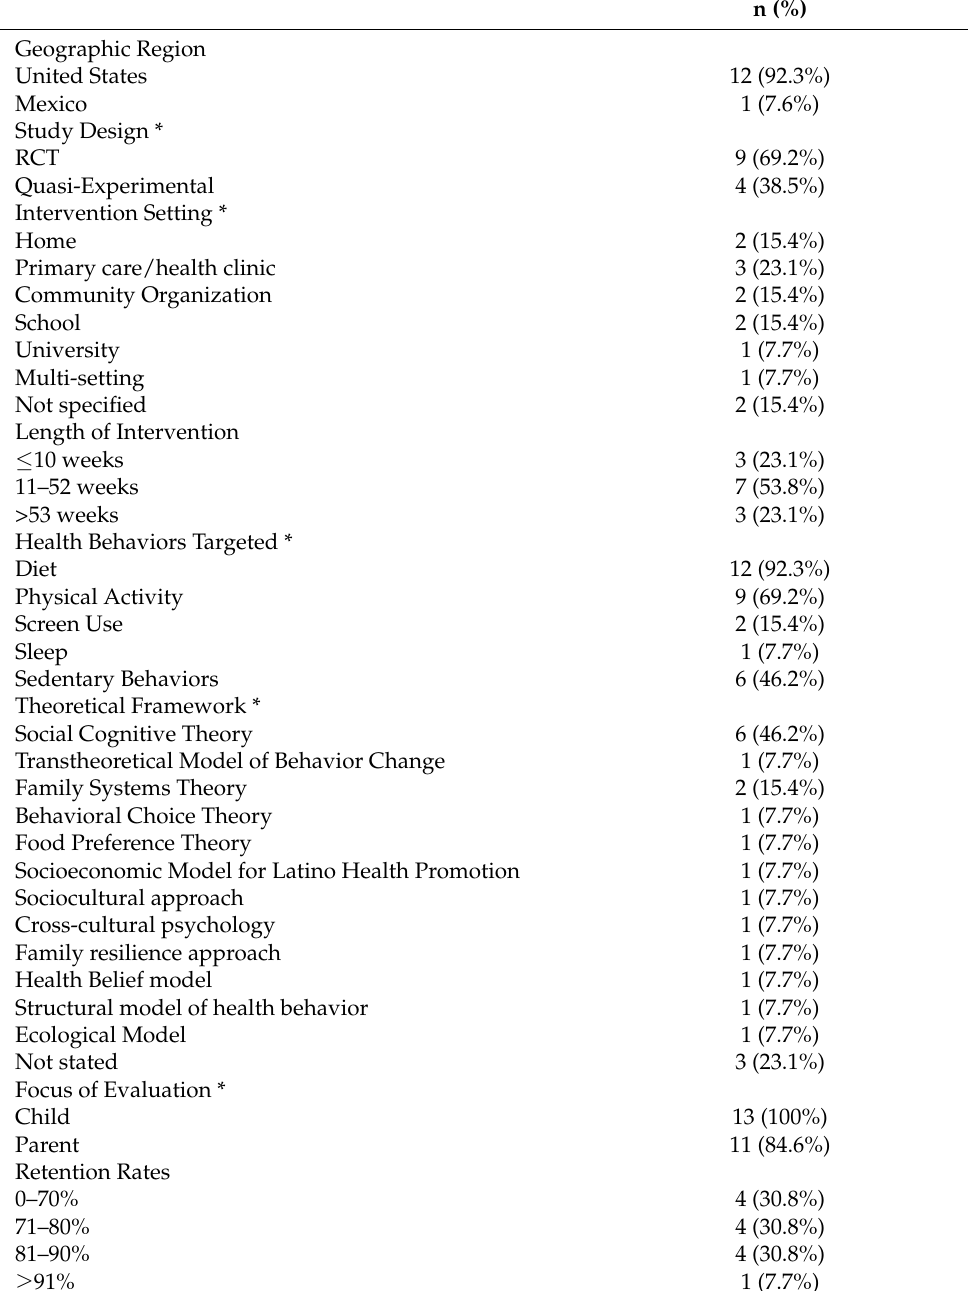
Table 1. Intervention characteristics (n =